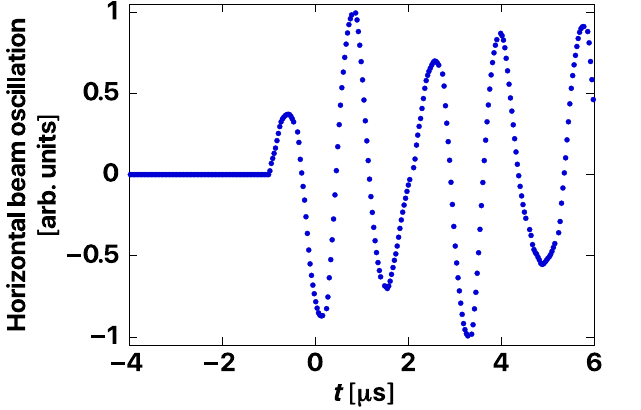
FIG. 21. Measured horizontal oscillation of the stored beam using the delayed-timing data sets in